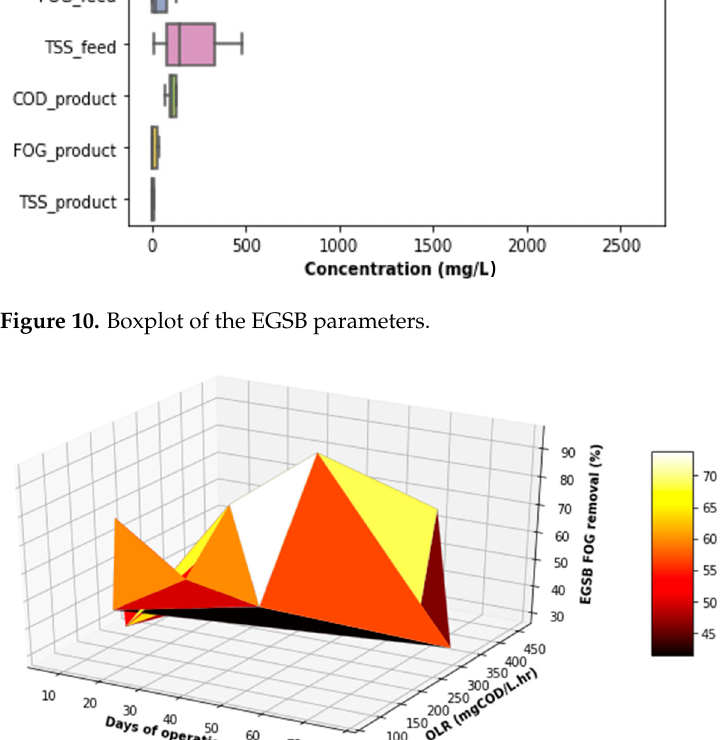
Figure 12. Variation in COD removal with differentiated OLR during the EGSB operational time.